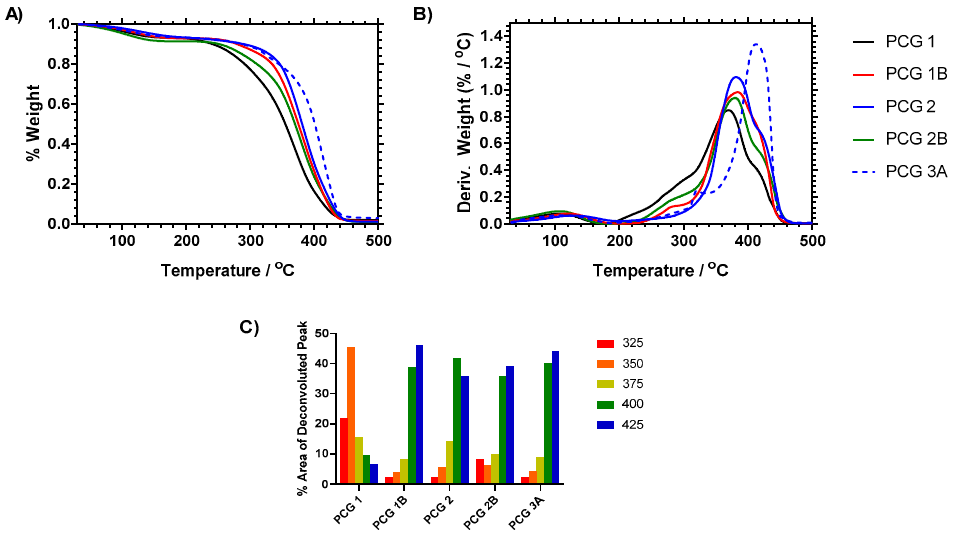
Figure 6. Thermogravimetric analysis of HEMA films (200–800 ◦ C). ( A ) Raw % weight loss across temperature ramp, ( B ) derivative weight loss across temperature ramp. Heating rate of samples 10 ◦ C. ( C ) %TGA (area of deconvoluted peak) for 25 ◦ C temperature ranges across the peak degradation step for HEMA gels.